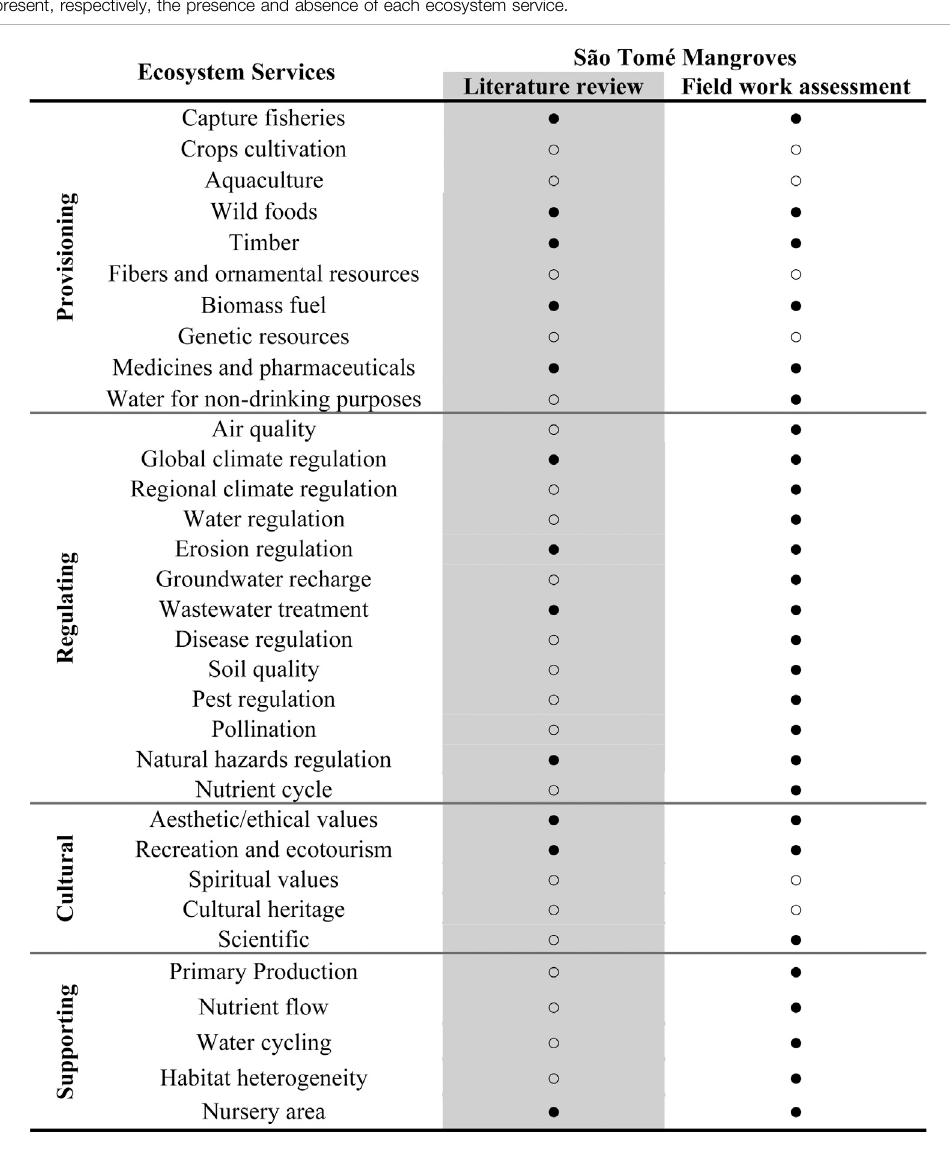
TABLE 5 | Ecosystem Services quanti fi ed in São Tomé Mangroves and values for comparison with mangroves in the tropical African region (indicators source: Table 1 ).